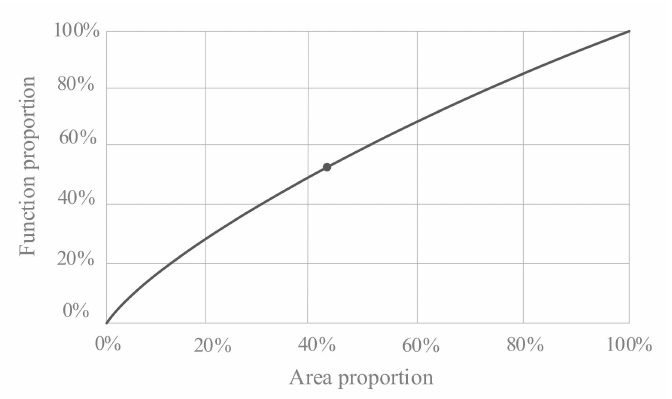
Figure 5. The schematic diagram of cumulative function and cumulative area, and the left units of the inflection point were the important water conservation space target